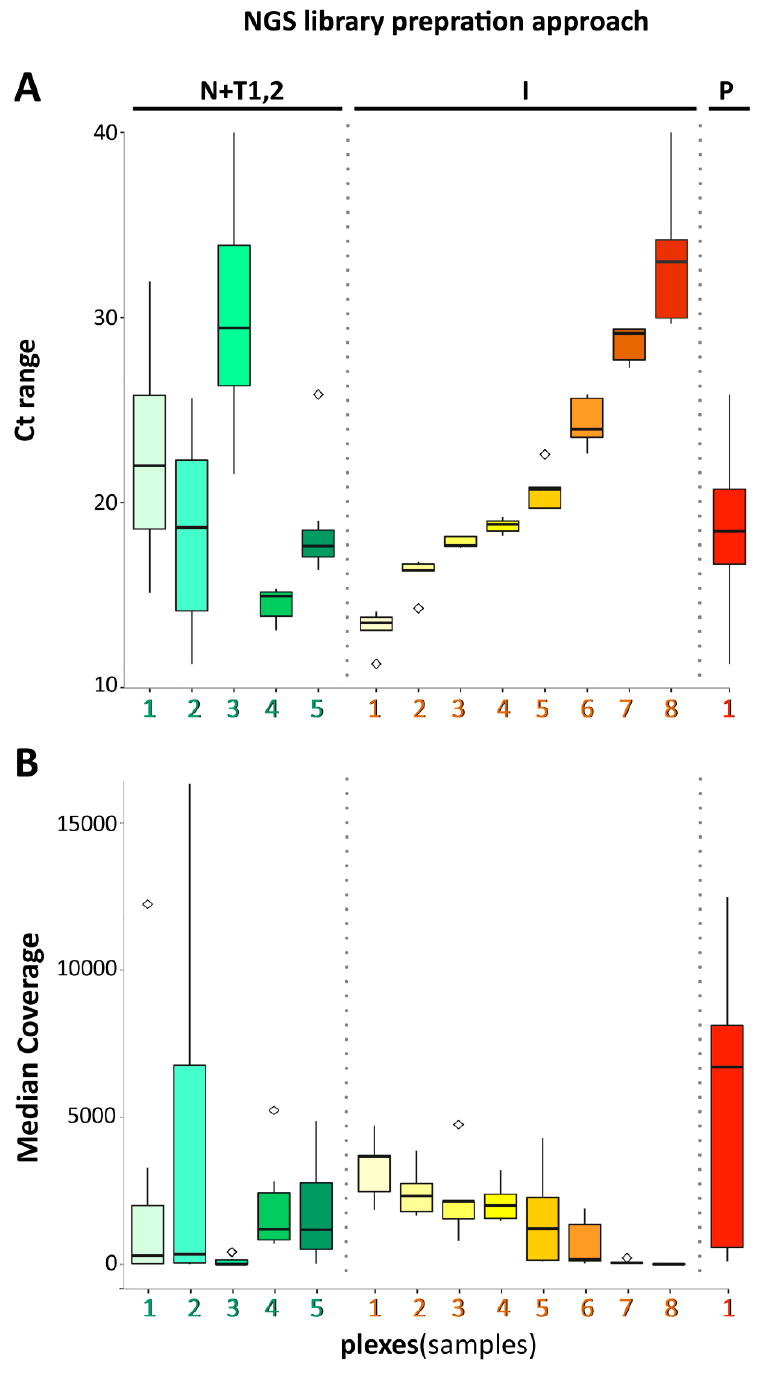
Figure 1. ( A ) Distribution of Ct values within the particular plexes of NEB + TWIST1,2; N + T1,2 (NEB + TWIST1 plex 1–3, NEB + TWIST2 plex 2–3), ILLUMINA; I (plex 1–8) and PARAGON; P (all the samples) approach. ( B ) Distribution of median coverage of reads which were mapped to target regions within the particular plexes of NEB + TWIST1,2; N + T1,2 (NEB + TWIST1 plex 1–3, NEB + TWIST2 plex 2–3), ILLUMINA; I (plex 1–8) and PARAGON; P (all the samples) approach. Box and Whiskers plots represent the median (horizontal line), 25th and 75th percentiles (boxes), maximum and minimum (whiskers) and outliers ( ♦